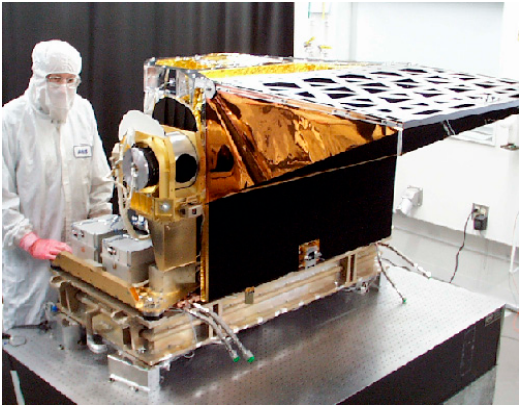
Figure 2. The Atmospheric Infrared Sounder (AIRS) shown at BAE SYSTEMS prior to delivery for spacecraft integration, has provided over 17 years of global daily SI-traceable IR radiances of Earth. The Focal Plane Assembly (FPA) contains 12 modules with 15 individual Photovoltaic (PV) HgCdTe line arrays of detectors in 2 × N element arrays where N ranges from 94 to 192 for PV HgCdTe, and 2 Photoconductive (PC) HgCdTe arrays with 1 × 144, and 1 × 130. Table 1 lists the modules. The 2 elements for each channel in the PV HgCdTe arrays are referred to as the A and B sides of the channel. During normal operations, any given channel’s signal is determined by a table, uploaded to the instrument, selecting either the A side, B side or a combination of the A and B side detectors (AB).